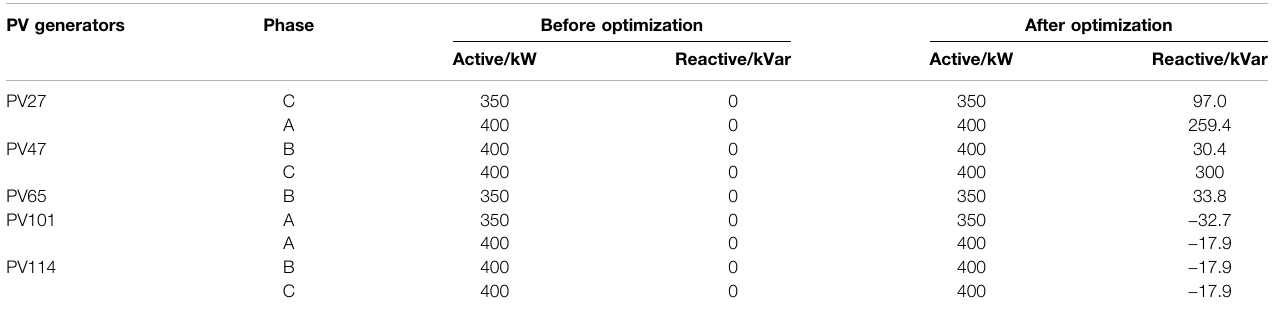
TABLE 1 | Comparison of active and reactive power outputs before and after